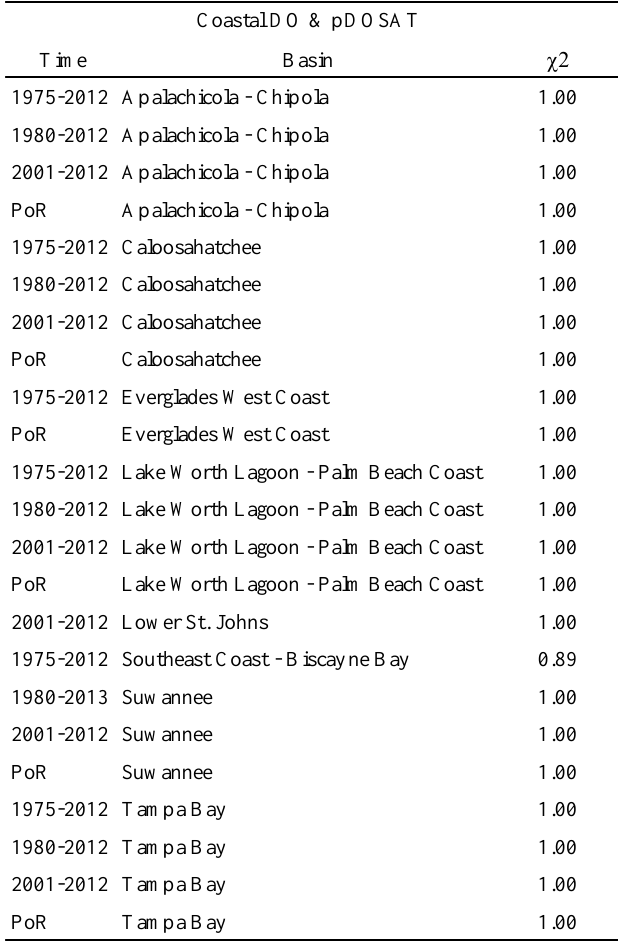
Table 5. Coastal DO & pDOSAT basin level analysis. Chi square test for independence was applied to those basins that could support the test to illustrate scalar